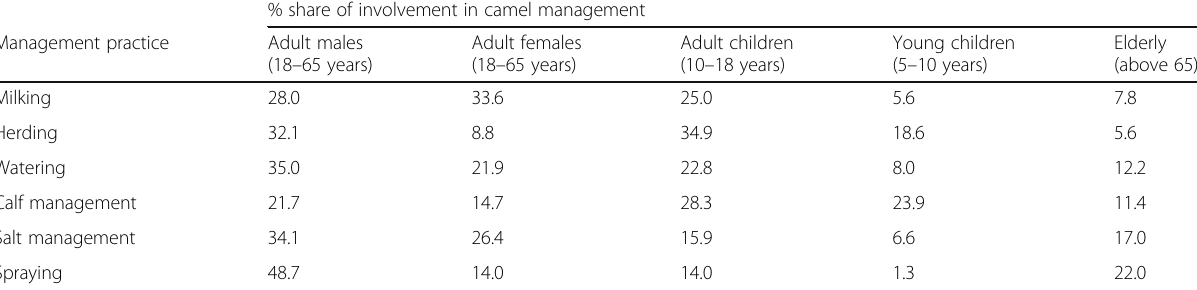
Table 4 Labour requirements for camel management % share of involvement in camel